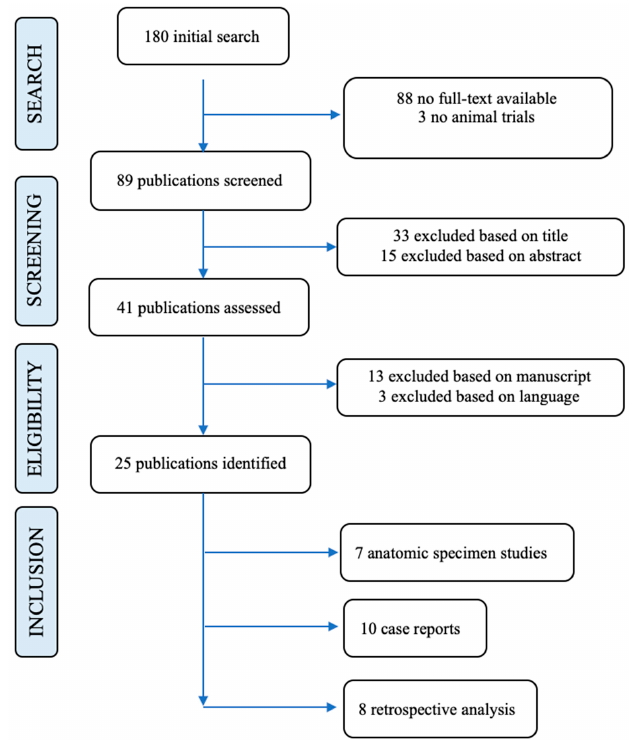
Figure 2. Represents the literature review of pronator teres in detail.